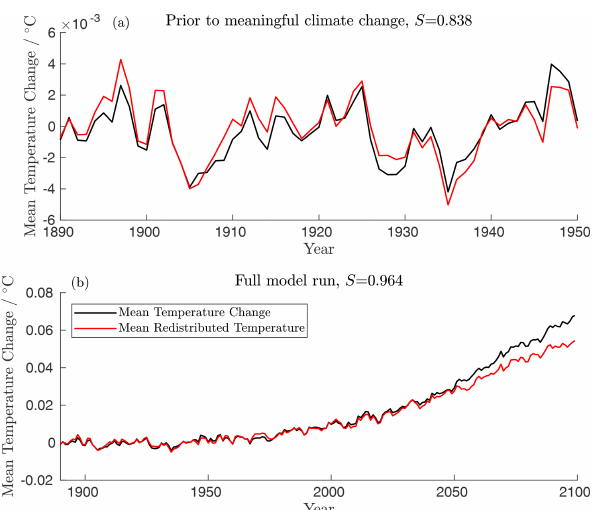
Figure E1. Total and redistribution-driven changes in the mean tem- perature of the unventilated ocean for the period before meaningful climate change (a) and the full model run (b) . Taylor skill scores for the periods presented are shown in panel